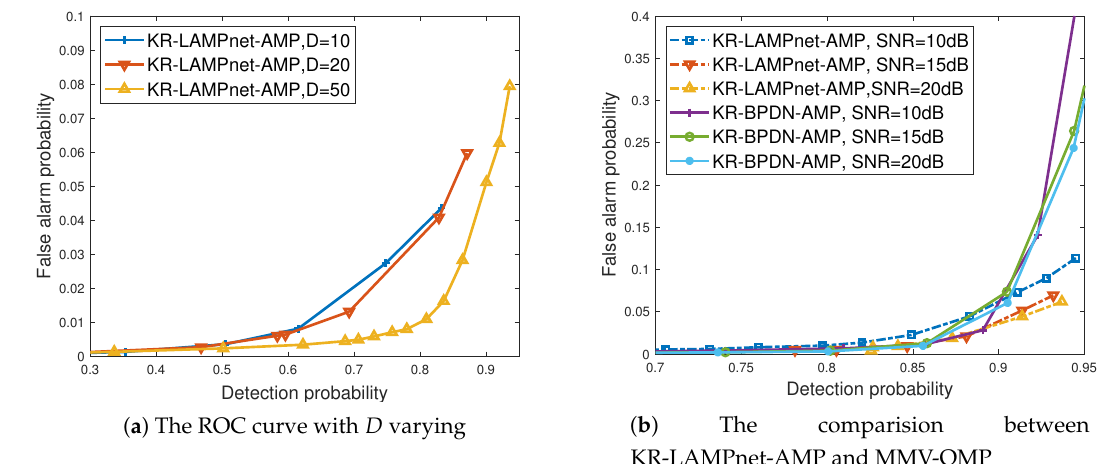
Figure 6. Comparision of KR-LAMPnet-AMP and